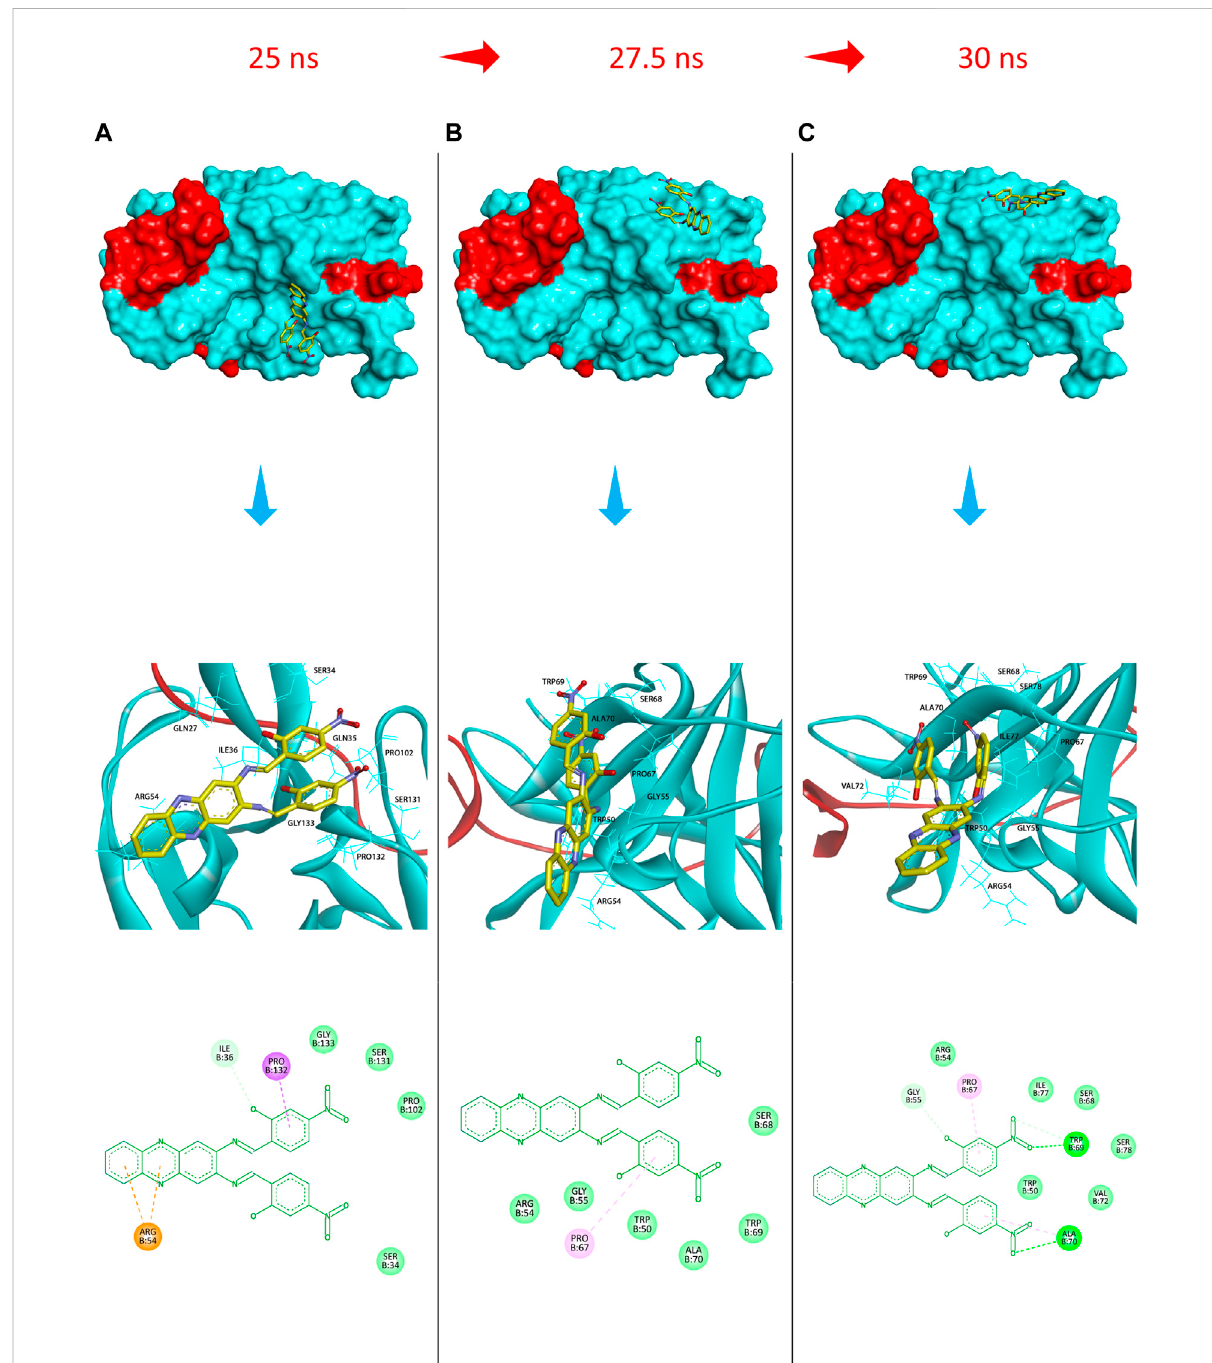
FIGURE 9 Protein surface, 3D, and 2D representations of the binding conformations of compound 5 (stick representation with yellow carbons) at the catalytic binding site of DENV2 NS2B-NS3 protease (ribbon representation; cyan for the NS3pro chain and red for the NS2B chain) at (A) 25 ns towards the S1 sub-pocket, (B) 27.5 ns towards the S2 sub-pocket, and (C) 30 ns as it maintains its binding towards the S2 sub-pocket. Frames were extracted using UCSF Chimera 1.15 and represented using BIOVIA Discovery